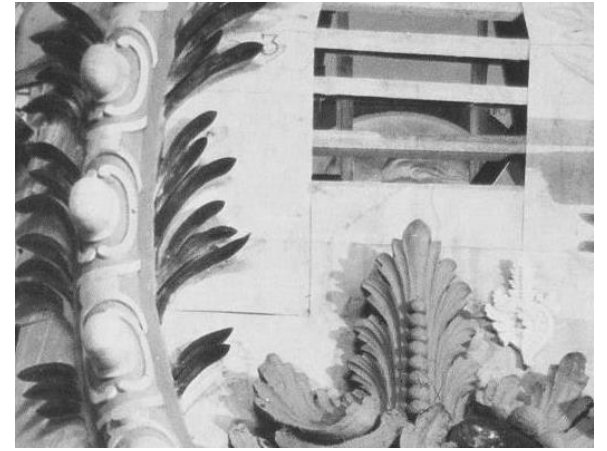
Figure 4. Fragment of a model combining the original and reconstructed decoration elements. Scale 1:1. © Boris Lobovikov